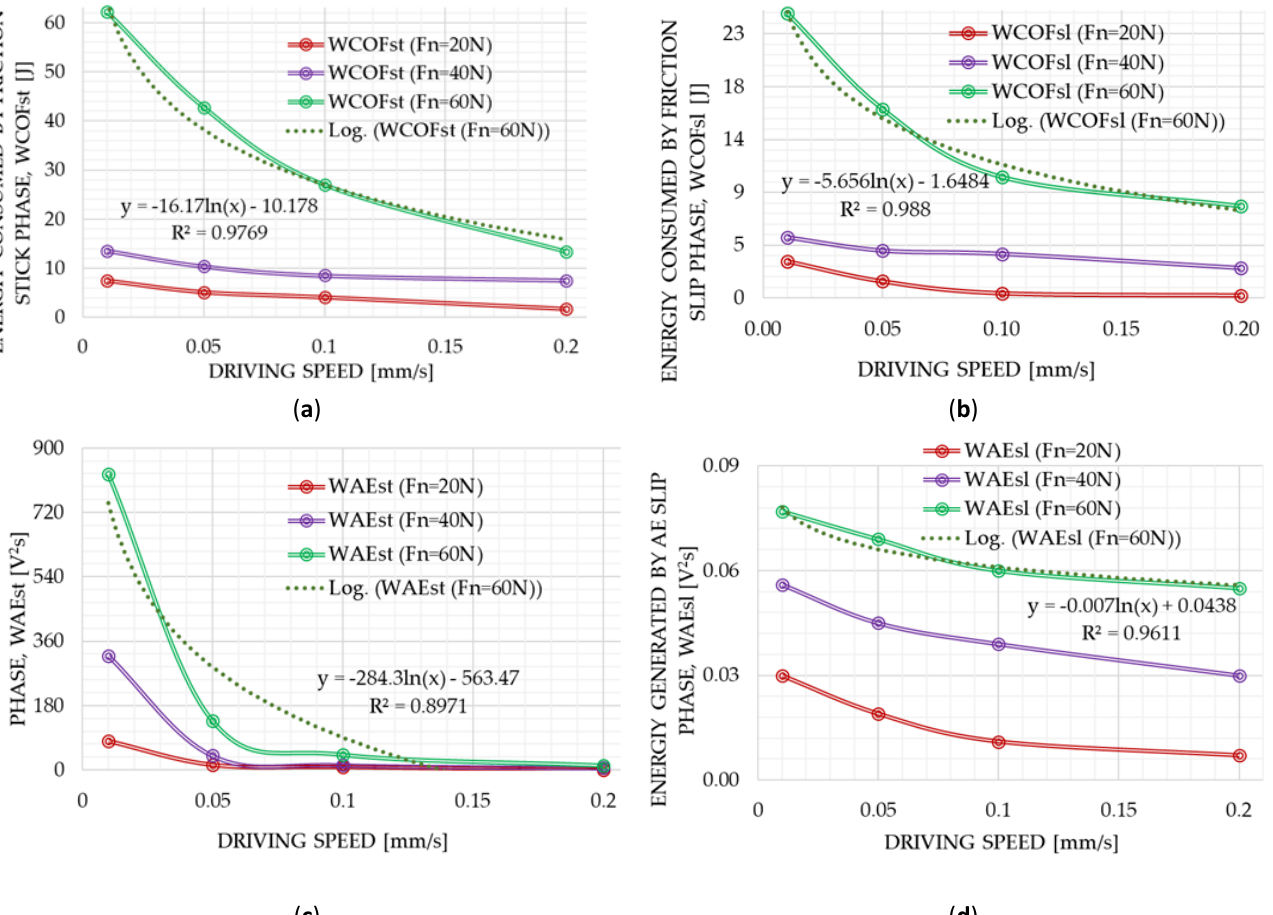
Figure 10. Variation in energies with different driving speeds (mm/s): ( a ) energy consumed by friction in slip phase, W COFsl (J), ( b ) energy consumed by friction in stick phase, W COFst (J), ( c ) energy generated by AE in slip phase, W AEsl (V 2 s), ( d ) energy generated by AE in stick phase, W AEst (V 2 s). Therefore, the energies seem to be related to each other and also to the amplitude of the stick–slip movement. The Pearson correlation coefficients were calculated between the energy generated by the acoustic emission, W AEsl (slip), W AEst (stick) and the energy consumed by friction, W COFsl (slip) W COFst (stick), between the SS amplitude ( µ v ) and these energies as well as between the AE sl and SS amplitudes and the sliding speed ( v slip ) (Table 4). Therefore, the energies appear to be related between themselves and also associated with the amplitude of the stick–slip motion. There was always a good correlation between both energies, with slightly reduced results in the stick phase when the 20 N force was applied. There was not always a burst of AE for the slide phase at this low normal force, so the correlation was not as good as for a greater normal load. In addition, at low normal forces, the deformations at the contact level were small; therefore, reduced tangential force effects caused a reduced AE